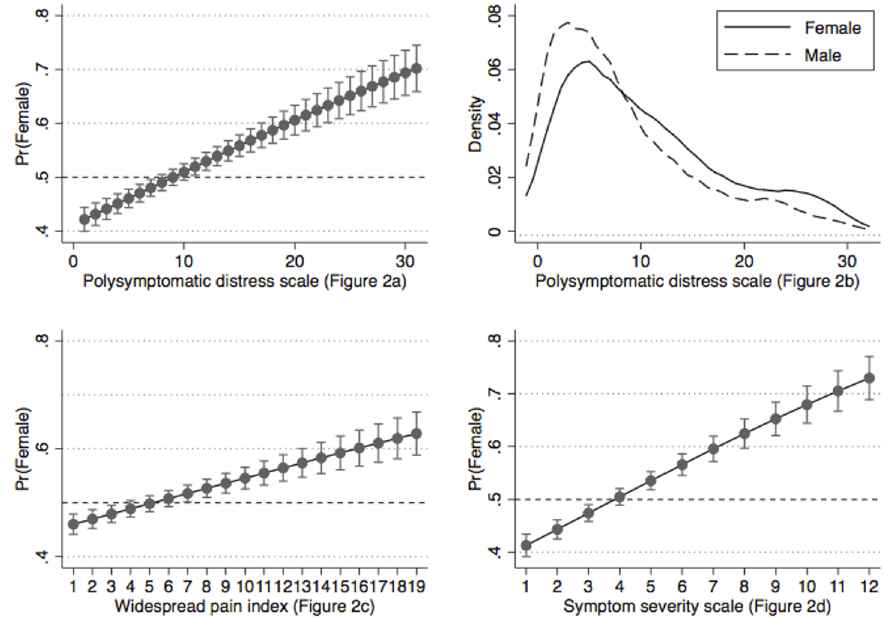
Fig 2. The relation of polysymptomatic distress (PSD) and its components to the sex of rheumatoid arthritis patients in the National Data Bank for Rheumatic Diseases (S2 File). (2a, 2c and 2d) The proportion of patients who are females increases with greater PSD, WPI and SSS scores. Pr = probability. (B) The distribution of PSD scores is greater and shifted to the right in women compared with men.